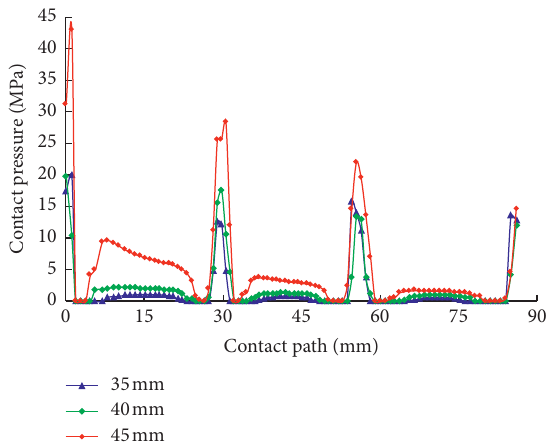
Figure 11: Change curves of contact pressure under different displacements.